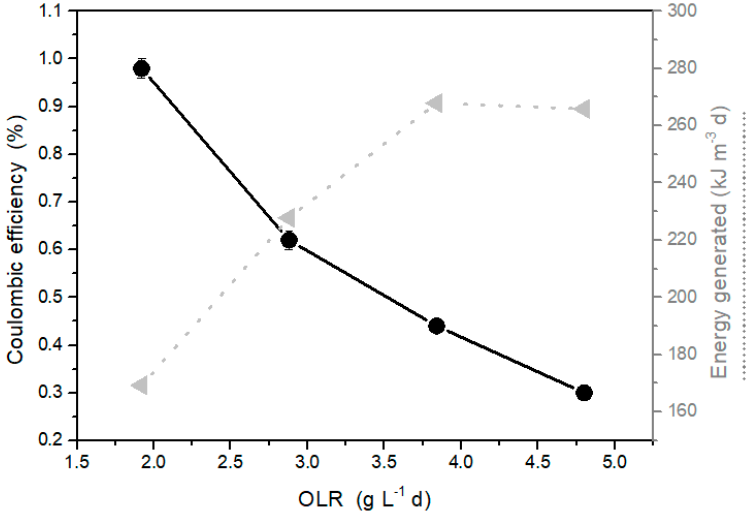
Figure 5. Electron conversion efficiency and energy generation from fermented wastewater under 1 k Ω of the external resistance [100].